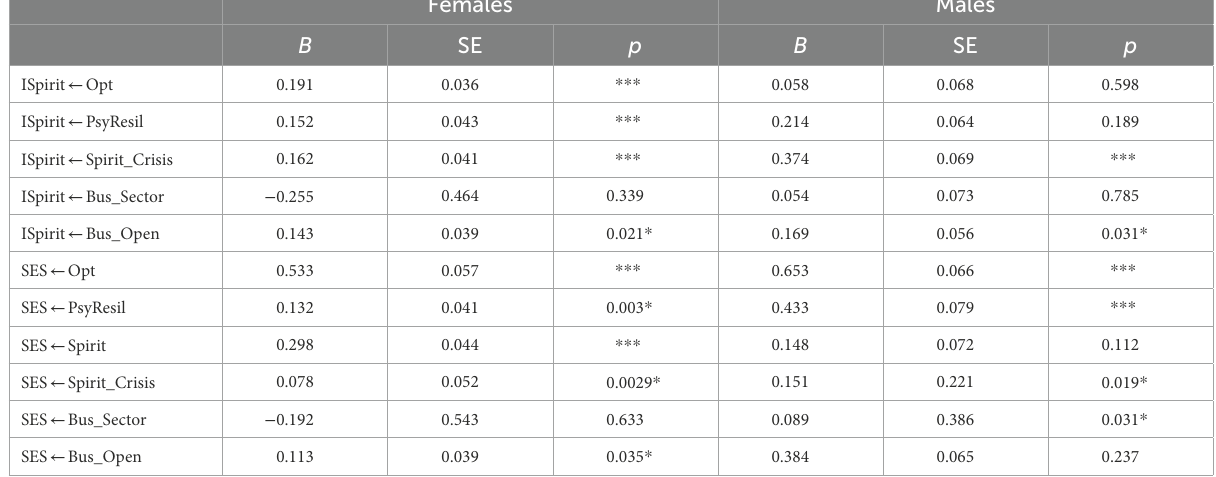
TABLE 3 Regression